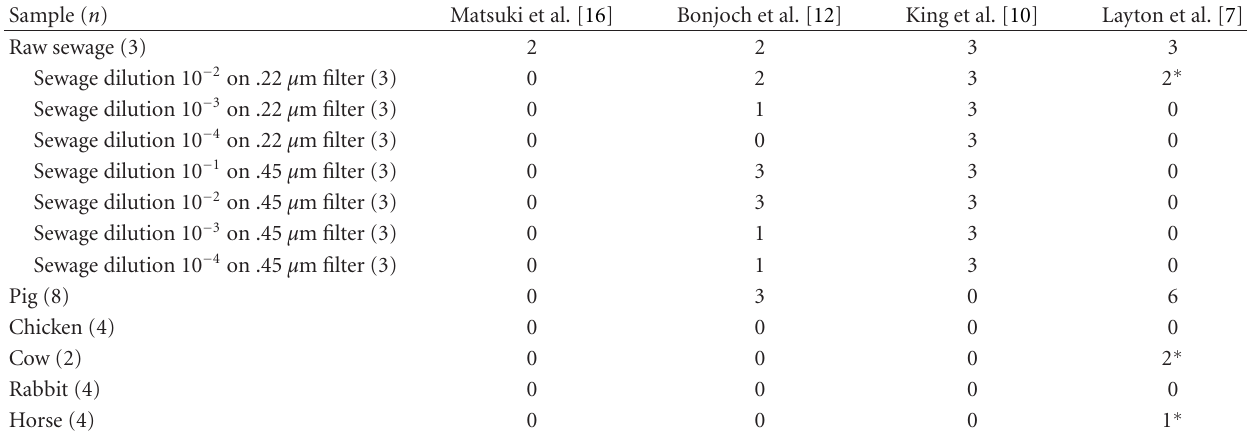
Table 3: Detection of human fecal bacteria ( B. adolescentis and HuBAC) PCR Products in environmental samples by multiplex- [10, 12] and single-PCR